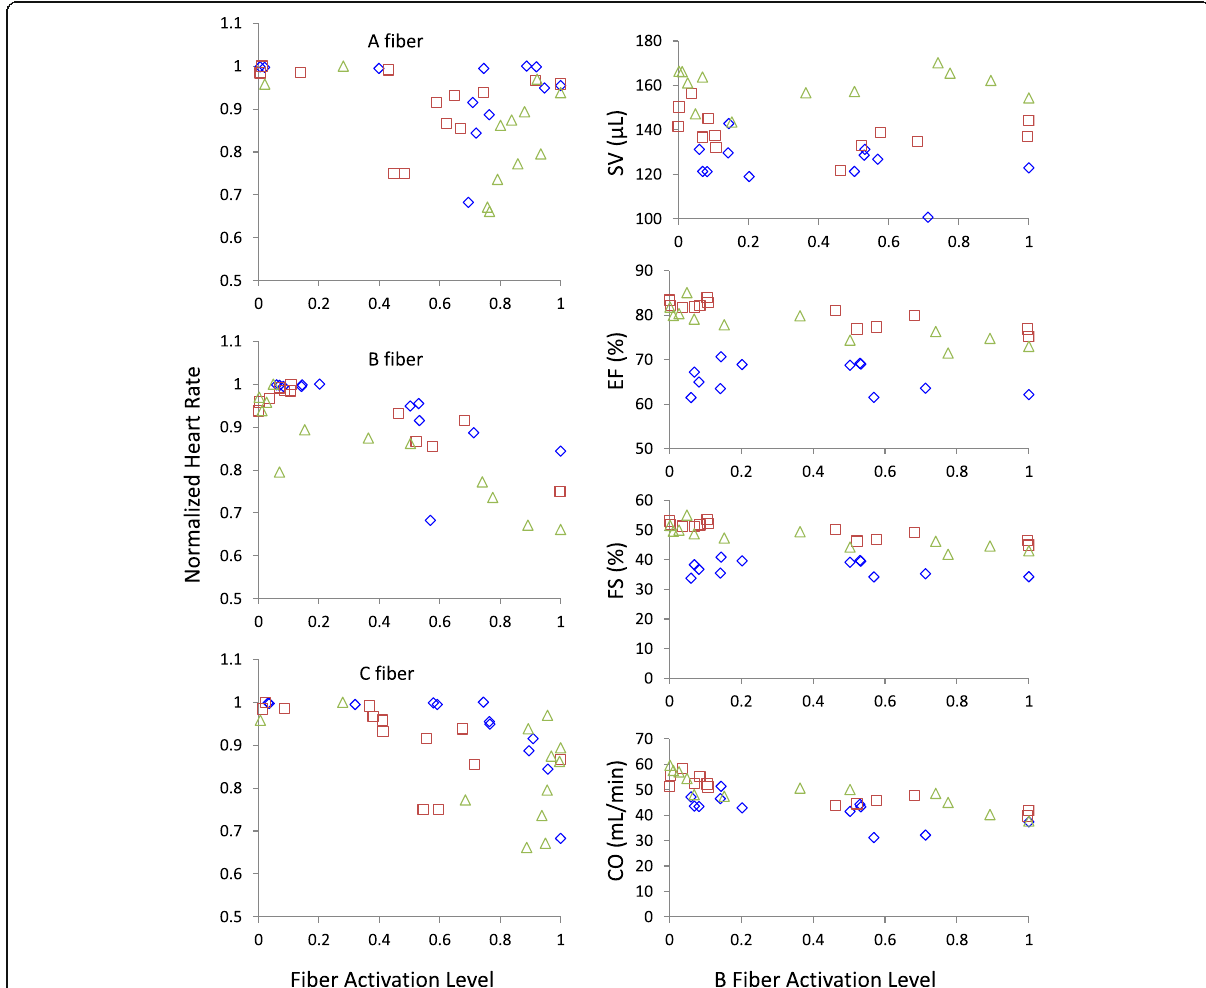
Fig. 5 Vagal activation-heart activity profiles. Left) Normalized heart rate was plotted against normalized fiber activation level from the same stimulation trial. Right) Various measures of heart activity were calculated from ultrasound recordings and plotted against B fiber activation. The data in this figure are from a separate group of animals ( n = 3, animals represented by different markers), presented without omission